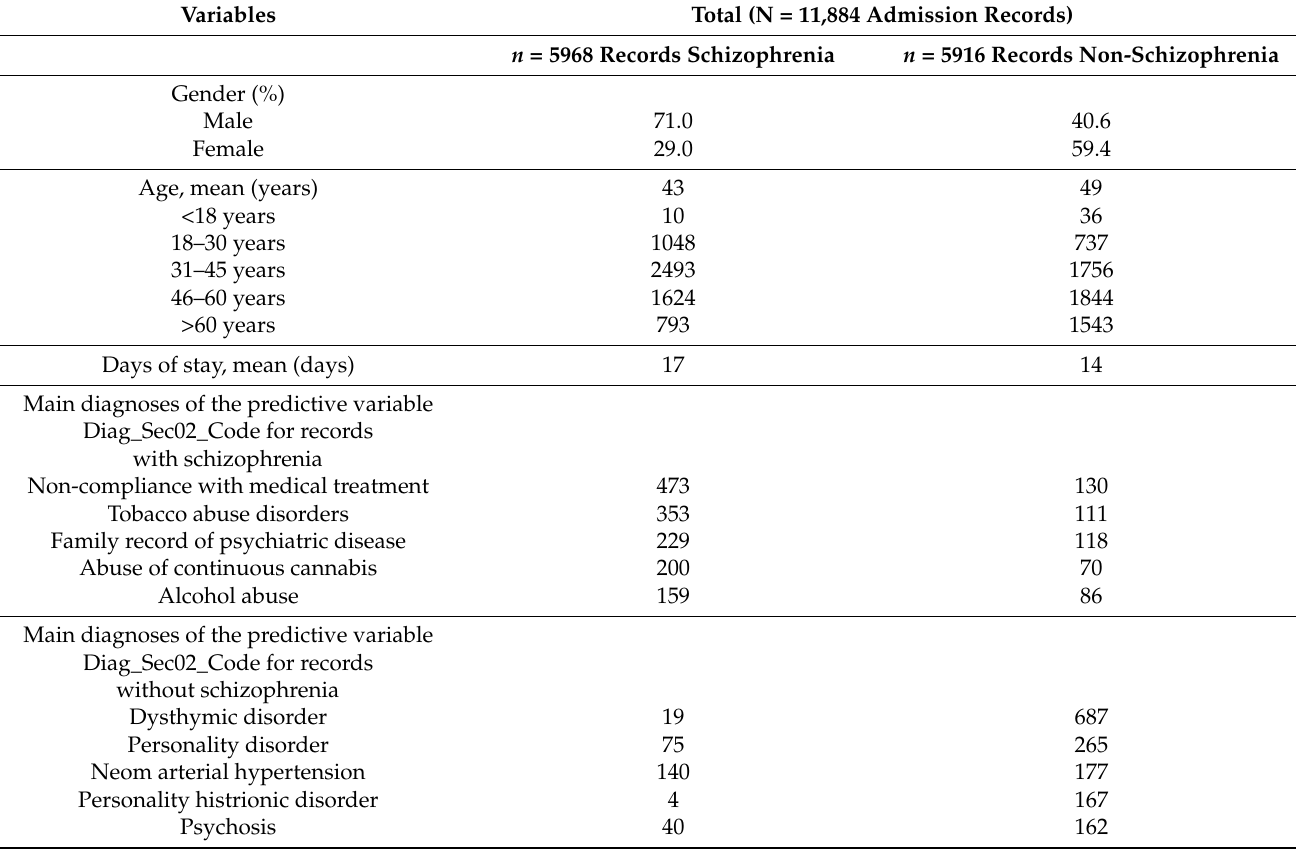
Table 3. Analysis of clinical